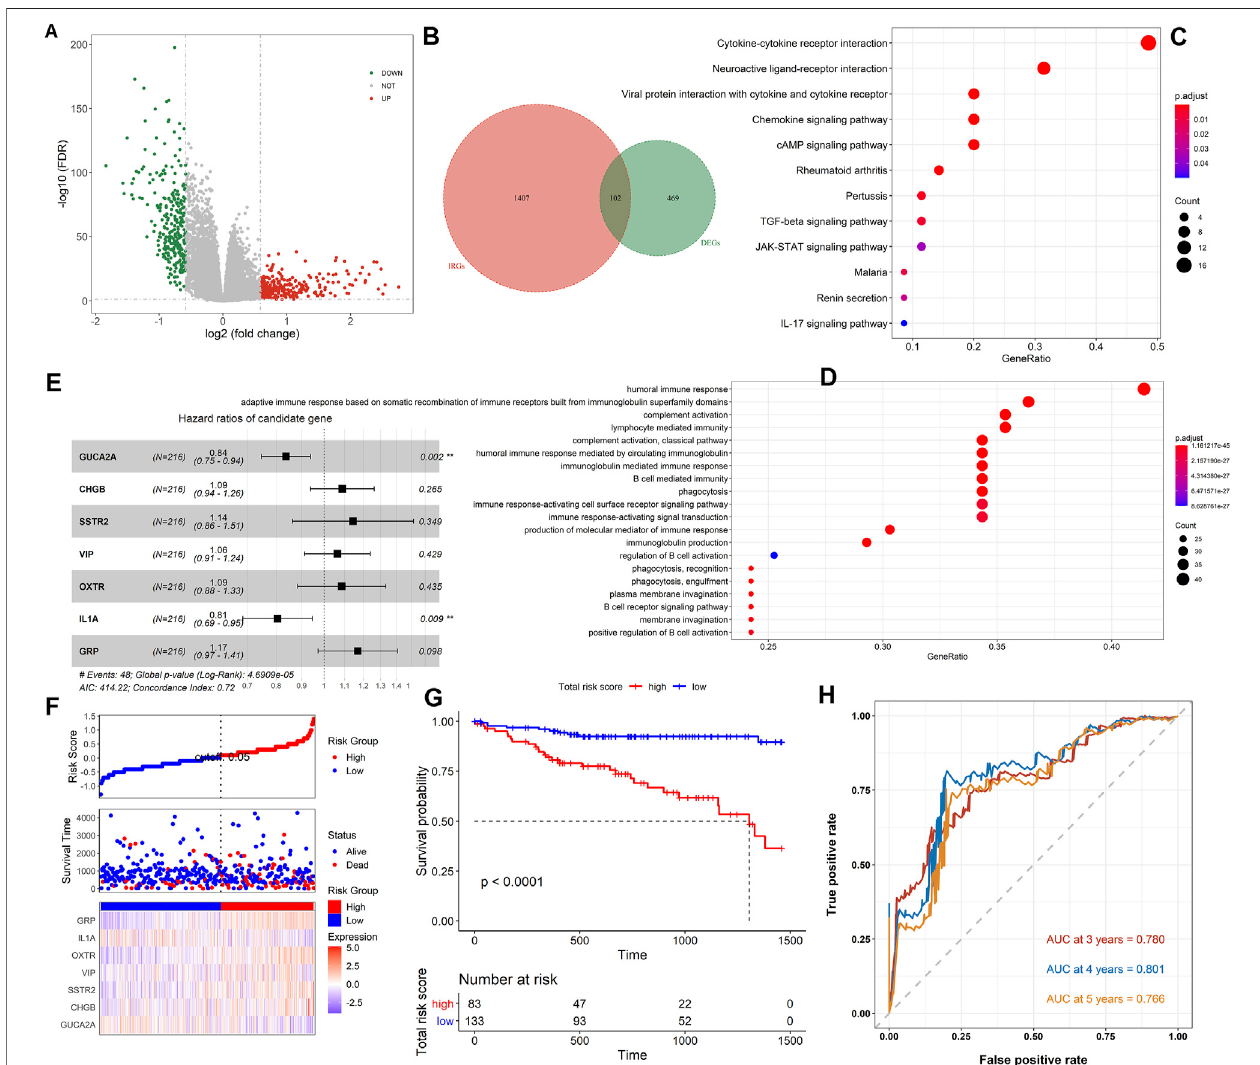
FIGURE 2 | Analysis of immune-related DEGs and construction of the immune-related prognostic model. (A) The volcano plot on all DEGs between the tumor and normal samples. The green dots represent downregulated genes, while the red dots represent upregulated genes. (B) The Venn diagram of the intersection between the DEGs and IRGs. (C) The KEGG pathway enrichment analysis of immune-related DEGs. (D) GO analysis of immune-related DEGs. (E) The forest plot showed the results of multivariate Cox analysis. (F) The distribution of the high- and low-risk score groups and their relationship with OS, and the expression pattern of seven prognostic signatures in high- and low-risk score groups. (G) The Kaplan – Meier curve revealed that OS in the low- risk score group was signi fi cantly higher than that in the high-risk score group. (H) Time-dependent ROC curve analysis of the immune-related risk score